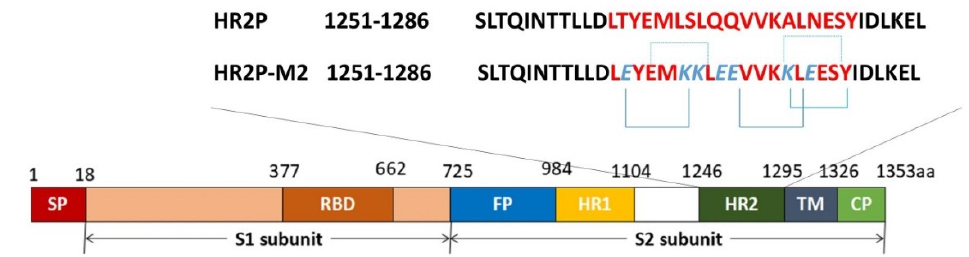
Figure 3. Schematic representation of MERS-CoV S (spike) protein S1 subunit and S2 subunit. RBD, receptor binding domain; FP, fusion peptide; HR1, heptad repeat 1 domain; HR2, heptad repeat 2 domain; TM, transmembrane domain; CP, cytoplasmic domain. The residue numbers of each region correspond to their positions in the S protein of MERS-CoV. HR2P, the peptide derived from the HR2 domain of MERS-CoV S protein S2 subunit; HR2P-M2, HR2P analogous peptide with mutations.